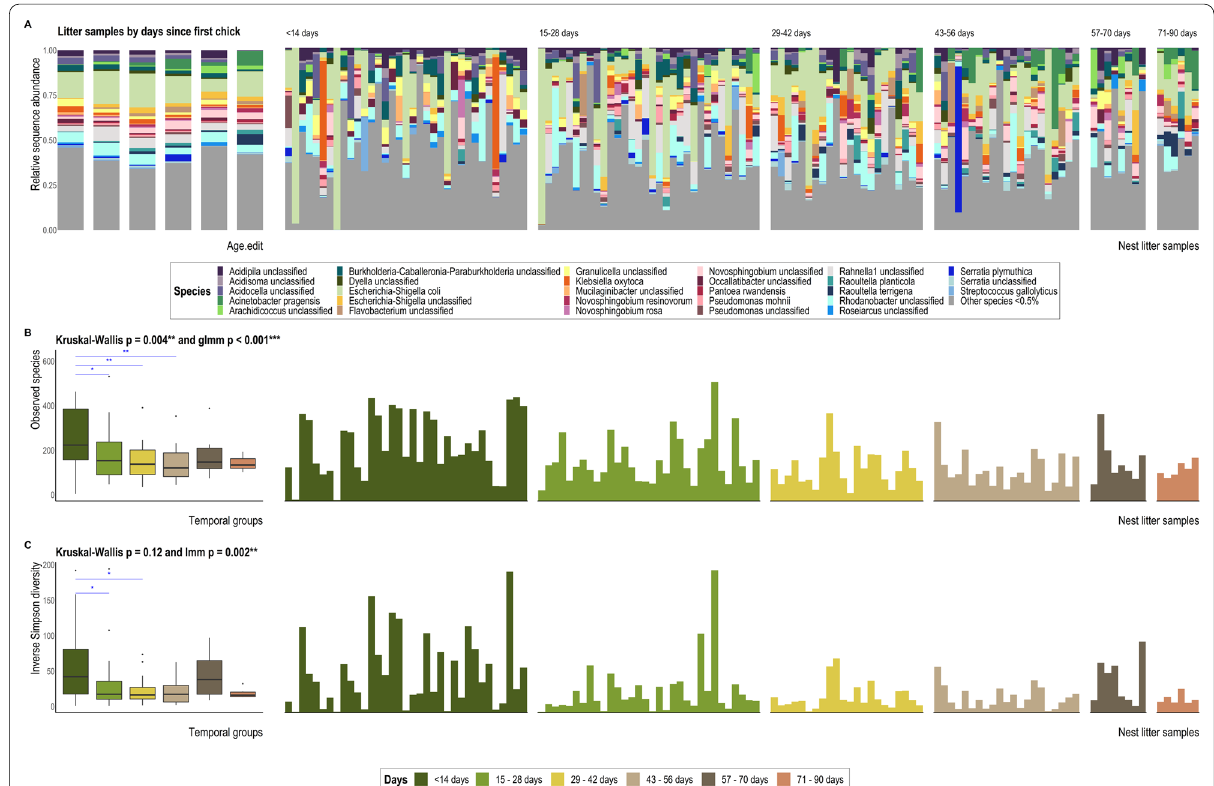
Fig. 5 A 16S rRNA gene sequence-based taxonomic distribution of bacteria by days since the nest sampled first housed a chick and individual nest litter faecal samples at the species level. Bars on the aggregated graph (left) are in the same order as the sample-level profile groups from left to right. Individual samples are ordered within groups chronologically and alphabetically. Taxa with mean relative 16S rRNA gene sequence abundance < 0.5% are grouped as ‘Other species’. B Observed richness and C Inverse Simpson (plotted on a log10 scale) alpha-diversity indices for litter samples grouped by days since the first chick was introduced to the nest. The y-axes for corresponding bar- and box-plots are identical. Significant Dunn’s test pairwise comparisons with Benjamini–Hochberg adjustment between groups in the box-plots are denoted by asterisks (* p < 0.05, ** p < 0.01, *** p < 0.001). Box-plot details are as described for Fig.